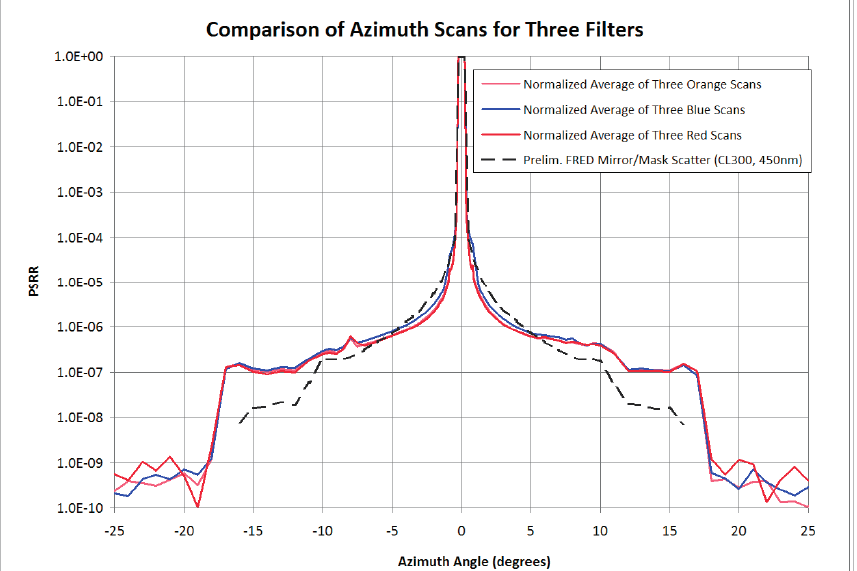
Figure 15. Stray light results. The scans (at three wavelengths, labeled by color in the plot) match the model (dashed lines) quite well for several orders of magnitude of the stray light response (point spread relative response, or PSRR).